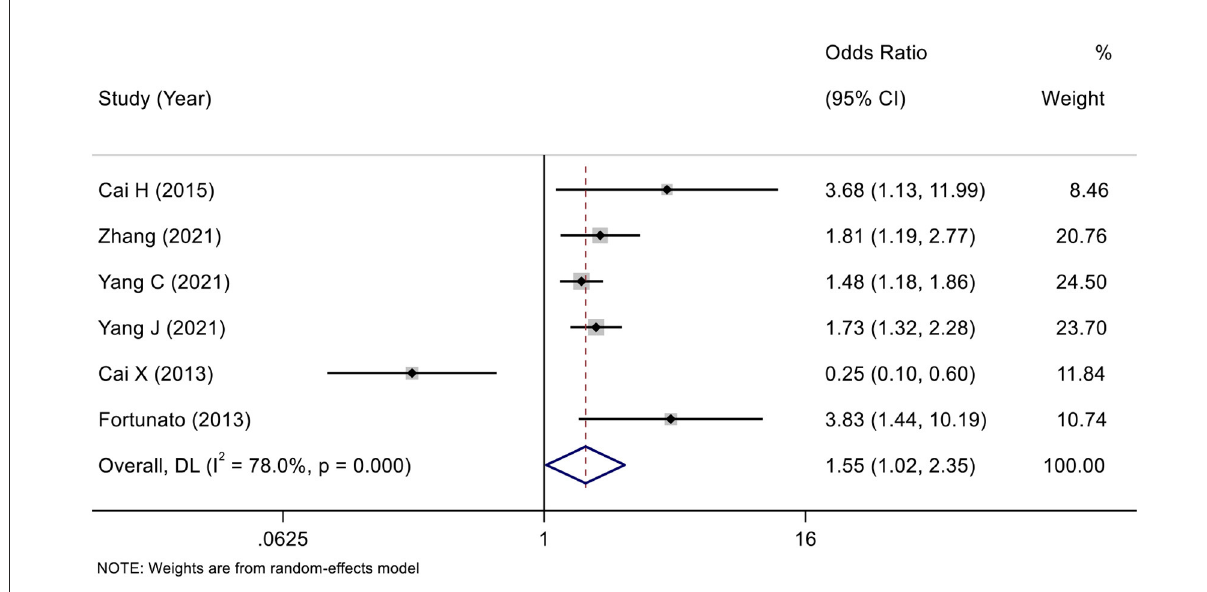
FIGURE4 Forest plot of the association between CXCL12 level as continuous variable and MACEs in patients with CAD (multivariate